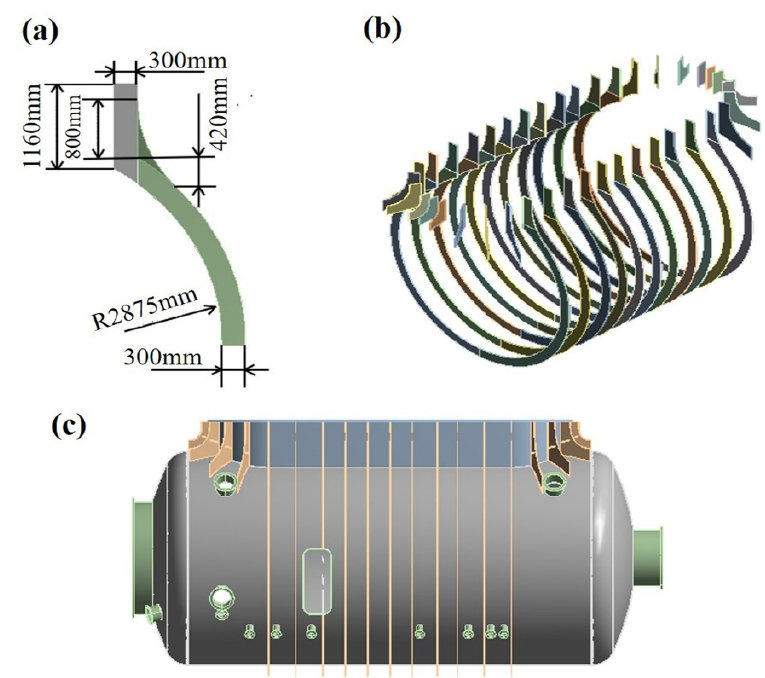
Figure 10. Reinforcing ribs and the reinforced test cabin: ( a ) reinforcing ribs; ( b ) arrangement of reinforcing ribs; ( c ) reinforced test cabin. Table 3. Comparison of the effect of the rationalized design of the ribs.